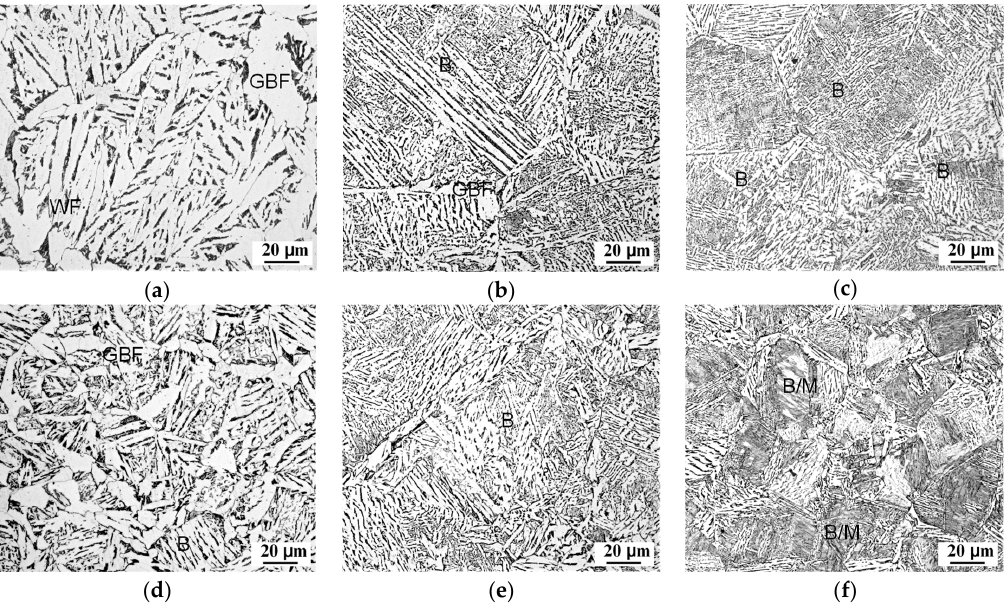
Figure 6. Microstructures of AC# steel formed at cooling rates of ( a, d ) 2 °C/s, ( b, e ) 5 °C/s, and ( c, f ) 15 °C/s with ( a – c ) no deformation and ( d – f ) 43% deformation at 1050 °C. Figure 7 shows the microstructures of TC# steels formed under different thermomechanical simulation conditions. Figure 7a–c and Figure 7d–f are microstructures without hot deformation and with the same deformation of 43% reduction, respectively. Figure 7g–i shows transformation products at the same cooling rate of 2 °C/s with different deformation parameters. The